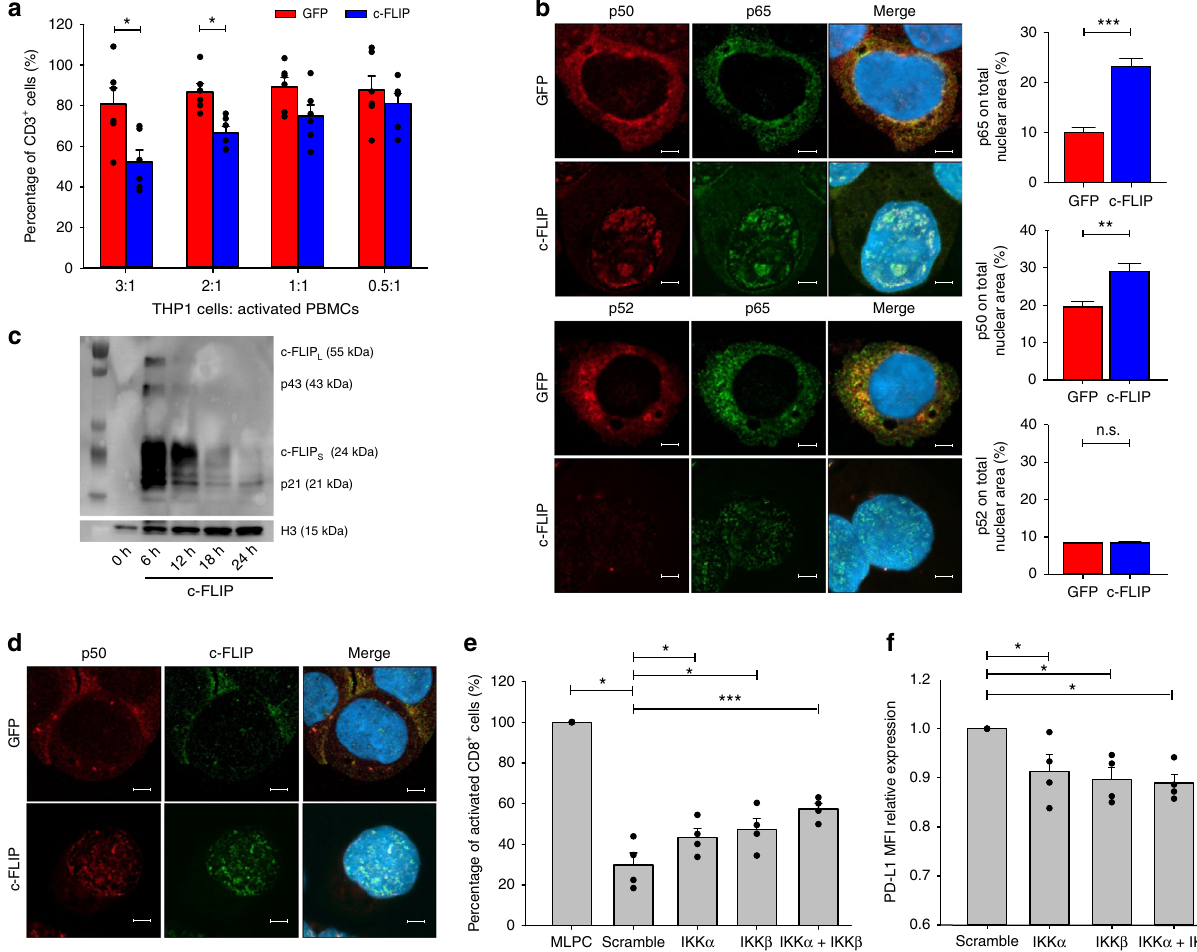
Fig. 5 FLIP activates the canonical NF- κ B pathway in myeloid cells. a Suppressive activity of THP1 cells transfected with c-FLIP RNA was measured by enumeration of an absolute number of human CD3 + T cells collected after in vitro co-culture. b Immuno fl uorescence confocal microscopy of p65 (red), p50 and p52 (green) nuclear translocation in transfected THP1 cells. c Nuclear c-FLIP protein expression by western blot in THP1 cells transfected with either GFP or c-FLIP RNA at different time points. d Immuno fl uorescence confocal microscopy of p50 (red) and c-FLIP (green) nuclear translocation in transfected THP1 cells. e CD11b + Ly6C + cells (M-MDSCs) were isolated from the spleen of MCA203 tumor-bearing, wild-type mice by fl ow sorter and transfected for 18 h with scramble, IKK α , IKK β , or the combination IKK α plus IKK β siRNAs. After transfection, cells were washed three times. M-MDSCs were co-incubated with peptide-stimulated CellTrace-labeled OT-I cells. Suppressive activity was measured by enumerating absolute numbers of CD8 + T cells collected after in vitro co-culture. f PD-L1 expression in transfected M-MDSCs. Data are presented either as mean ± s.e.m of three independent experiments ( a ) or as mean ± s.e.m of four independent experimental transfections ( e , f ) where each plot refers to CD11b + Ly6C + cells isolated from the pooled spleens of three tumor-bearing mice. Original images × 800 for all panels ( b , d ). * P < 0.05, ** P < 0.01; *** P < 0.001; n.s., not signi fi cant, by Mann – Whitney test ( a , b , e , f